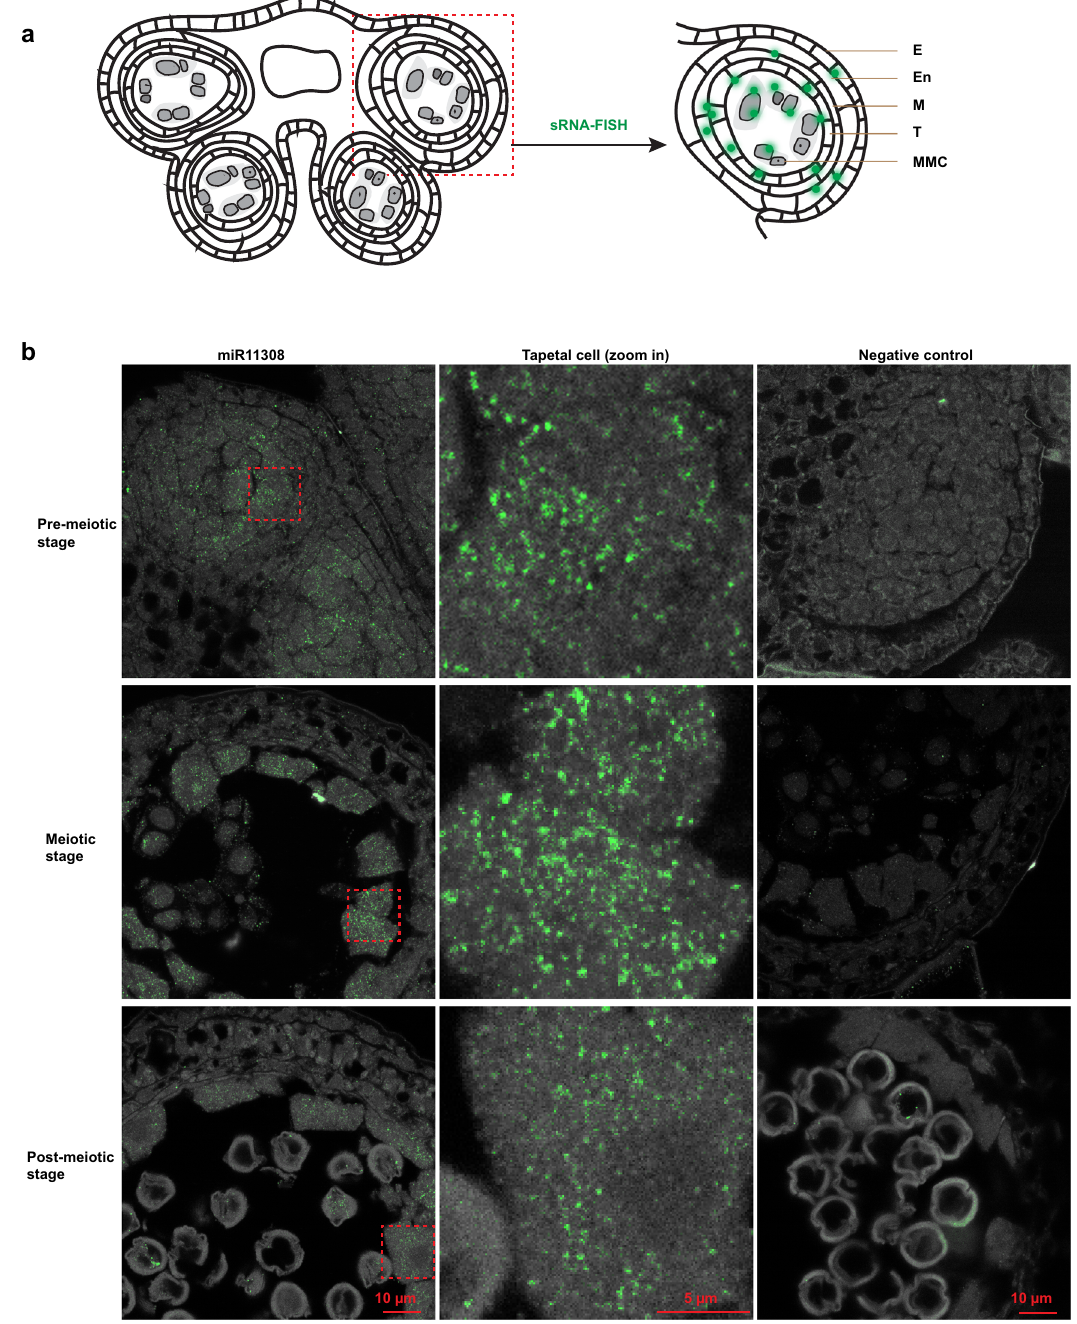
Fig. 2 miR11308 accumulates in microspore mother cells, meiocytes, and tapetal cells in the anthers of wild strawberry. a Schematic diagram of the sRNA-FISH method in anther stages shown in b . E: epidermis, En: endodermis, M: middle layer, T: tapetum, MMC: microspore mother cell. b In situ hybridization of miR11308 in pre-meiotic, meiotic, and post-meiotic anther stages. The experiment was repeated twice with similar